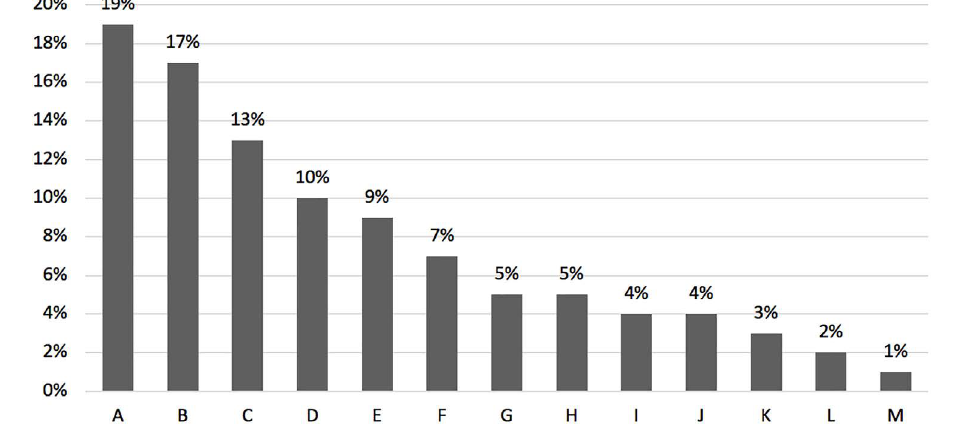
Figure 2. Frequency of which issues are revealed by photographs produced by future teaching professionals. Source: